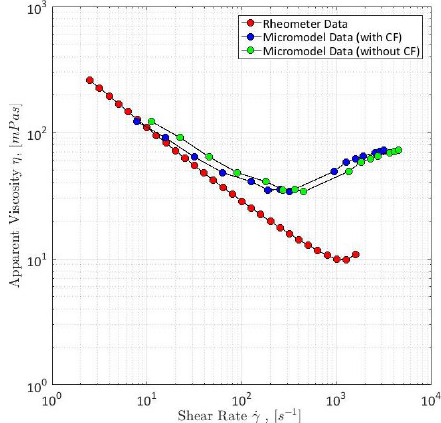
Figure 11. Example for shear rate correction (CF = correction factor) [69].